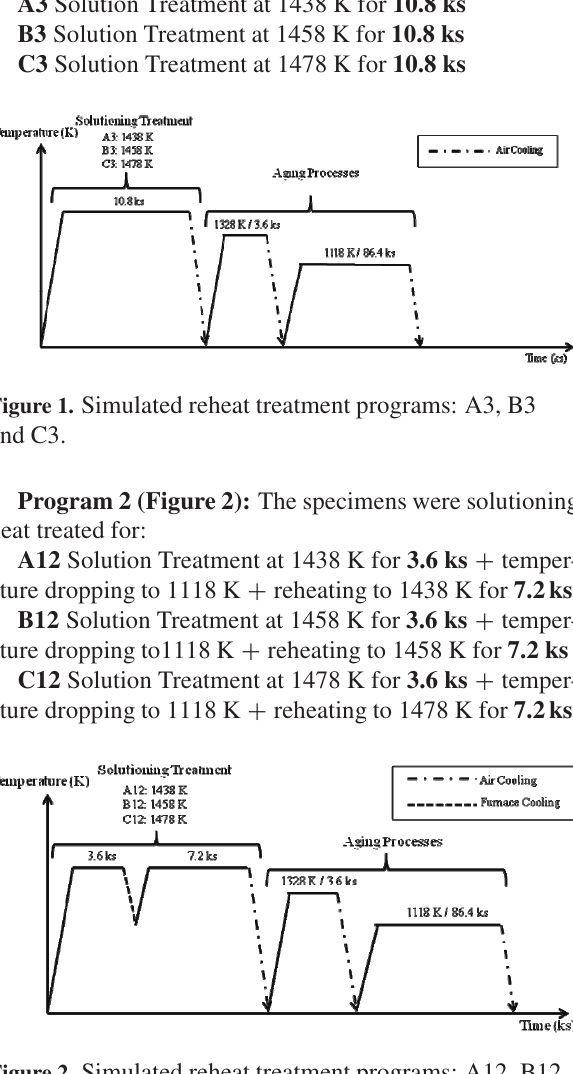
Figure 2. Simulated reheat treatment programs: A12, B12 and C12.